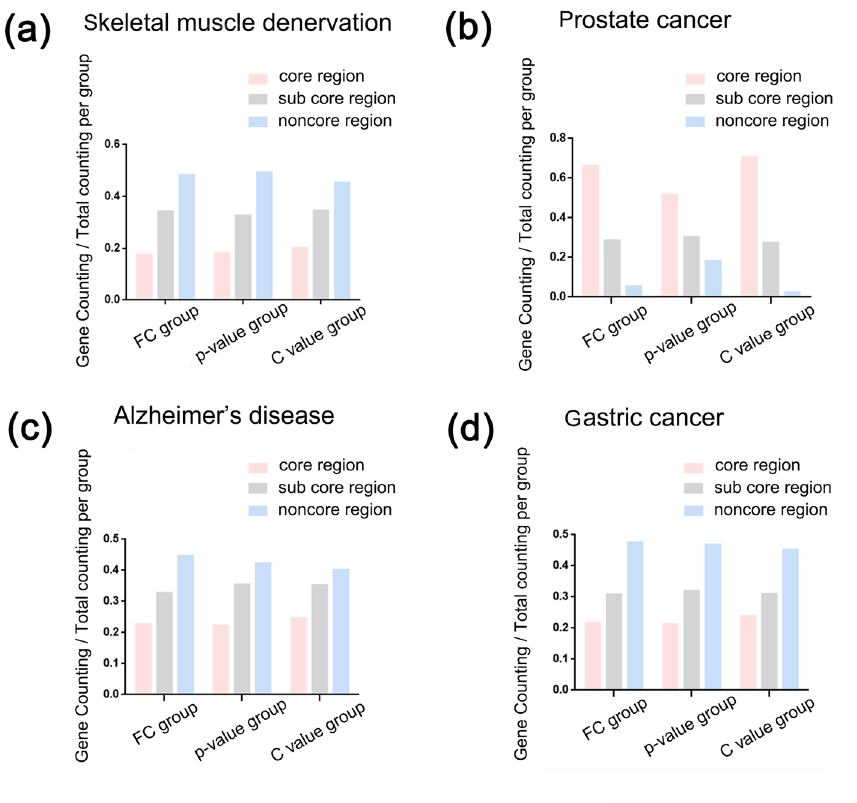
Figure 3. Statistics on the distribution of each group in the PPI network. ( a ) Skeletal muscle denervation. ( b ) Prostate cancer. ( c ) Alzheimer’s disease. ( d ) Gastric cancer. The ratio of the number of genes in each group in different regions.